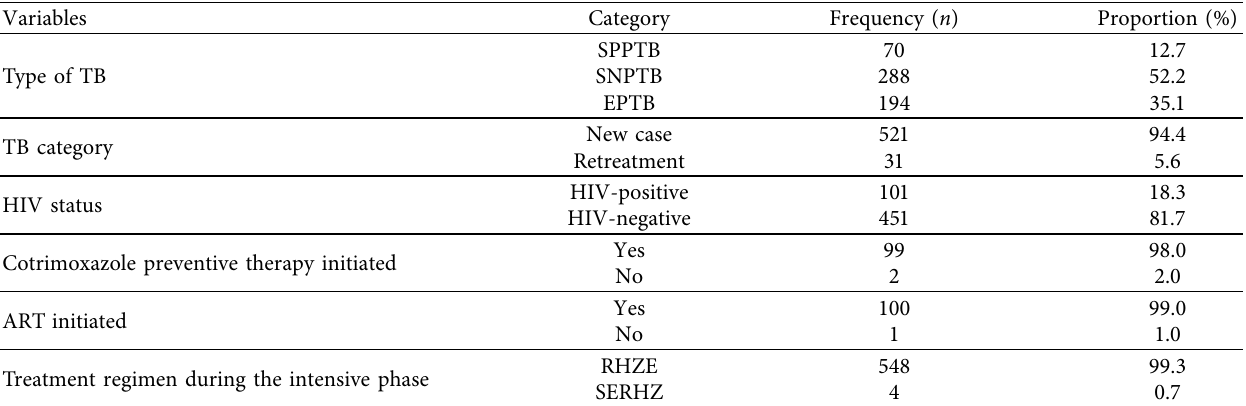
Table 2: Clinical characteristics of TB patients at Tefera Hailu Memorial General Hospital, Sekota town, Northeast Ethiopia from 2015 to 2021.